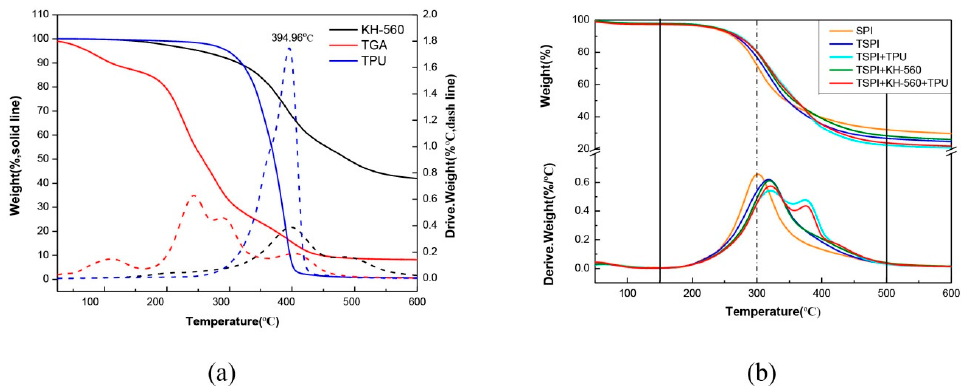
Figure 6. ( a ) TG (Thermogravimetry) and DTG (Derivative Thermogravimetric) curves of TPU, triglycidylamine (TGA), γ -(2,3-epoxypropoxy) propyltrimethoxysilane (KH-560), and ( b ) TG and DTG curves of the cured different adhesives.